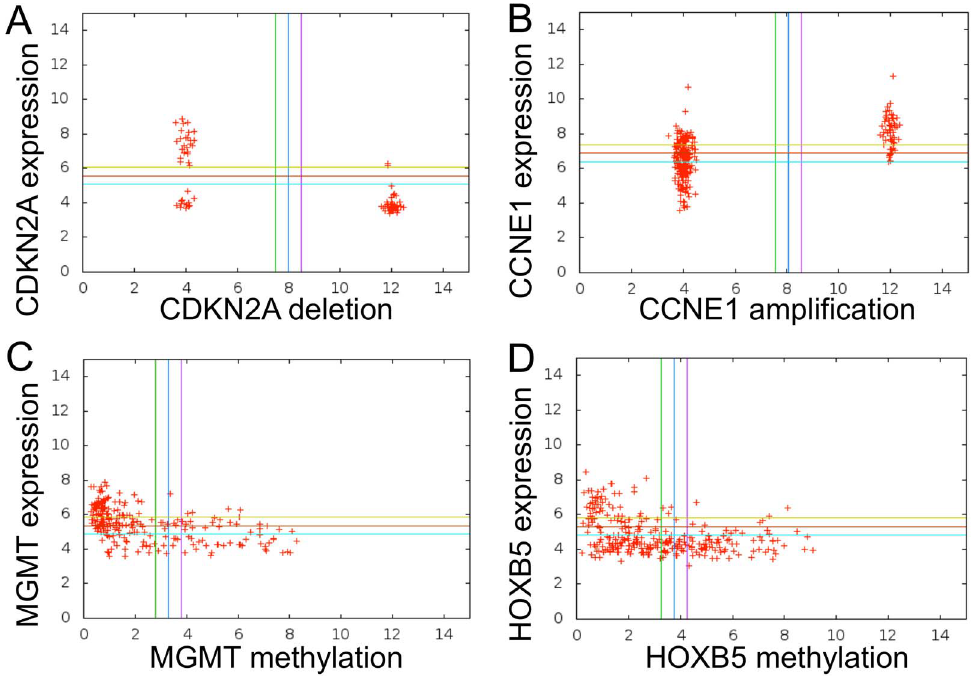
Figure 3. Boolean Implications Between Copy Number Alterations/DNA Methylation and Expression of the Same Gene. Boolean implications between variables are easily verified by inspecting scatter plots. Data for deletions and amplifications were rescaled: a value of 12 implies gene deletion or amplification; a value of 4 implies no somatic copy number change for the gene. Gaussian noise was added so the points do not fall exactly on 4 and 12 to allow easier visualization. The beta-values of methylation (which is how TCGA reports methylation data) were scaled by a factor of 10. (A) HILO Boolean Implication between CDKN2A deletion and CDKN2A expression in TCGA GBM data set. (B) HIHI Boolean Implication between CCNE1 amplification and CCNE1 expression in TCGA OV data set. (B) HILO Boolean Implication between MGMT methylation and MGMT expression in